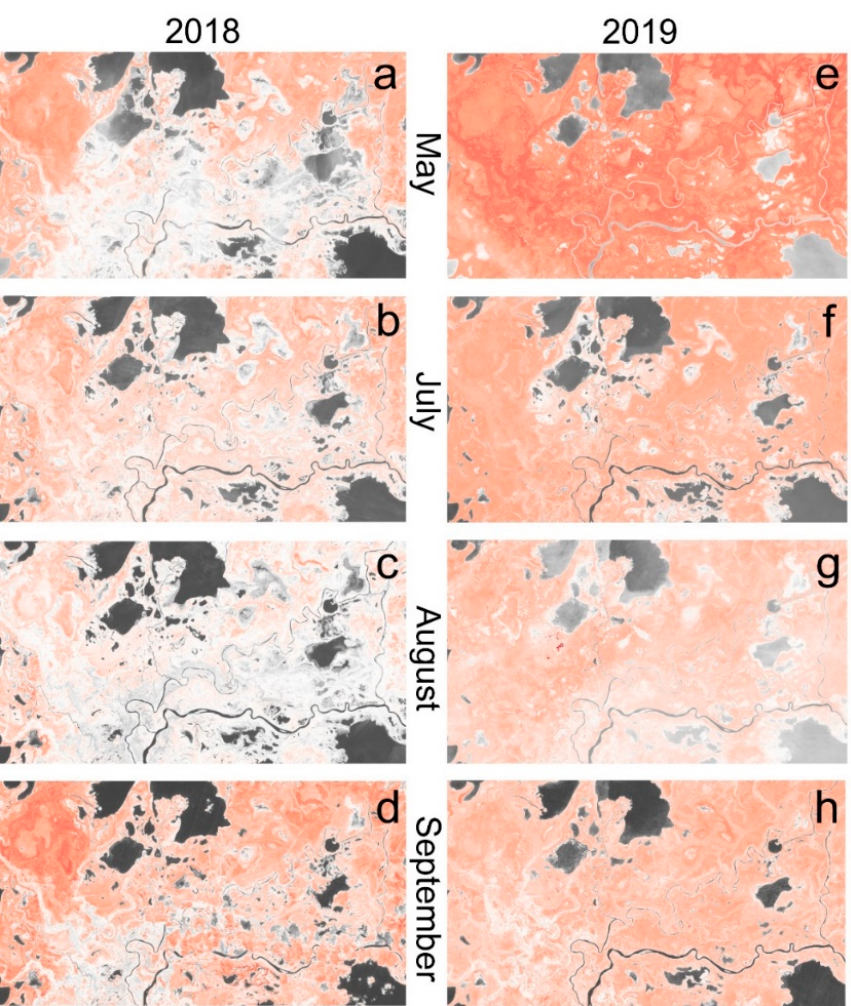
Figure 6. Summary images of changes to the Modified Normalized Difference Water Index (MDNWI) over the two time periods used in this work: May, July, August and September images for 2018 ( a – d ) and 2019 ( e – h ), respectively. Grey indicates increasing wetness and red increasing dryness; all images stretched from − 1 (drier—red) to 1 (wetter—grey).